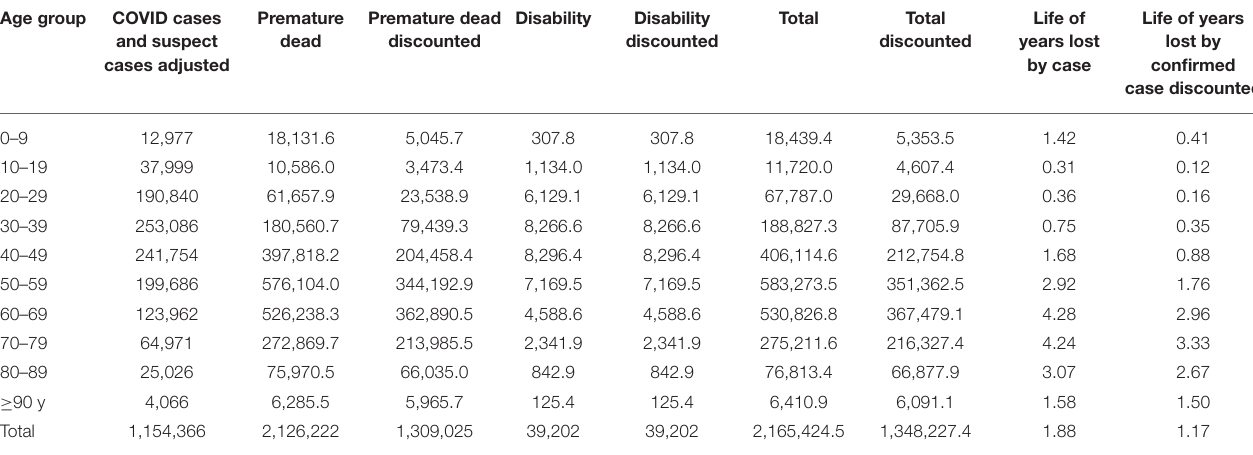
TABLE 4 | Total disability-adjusted life years (DALYs) by COVID-19 case. Age group COVID cases and